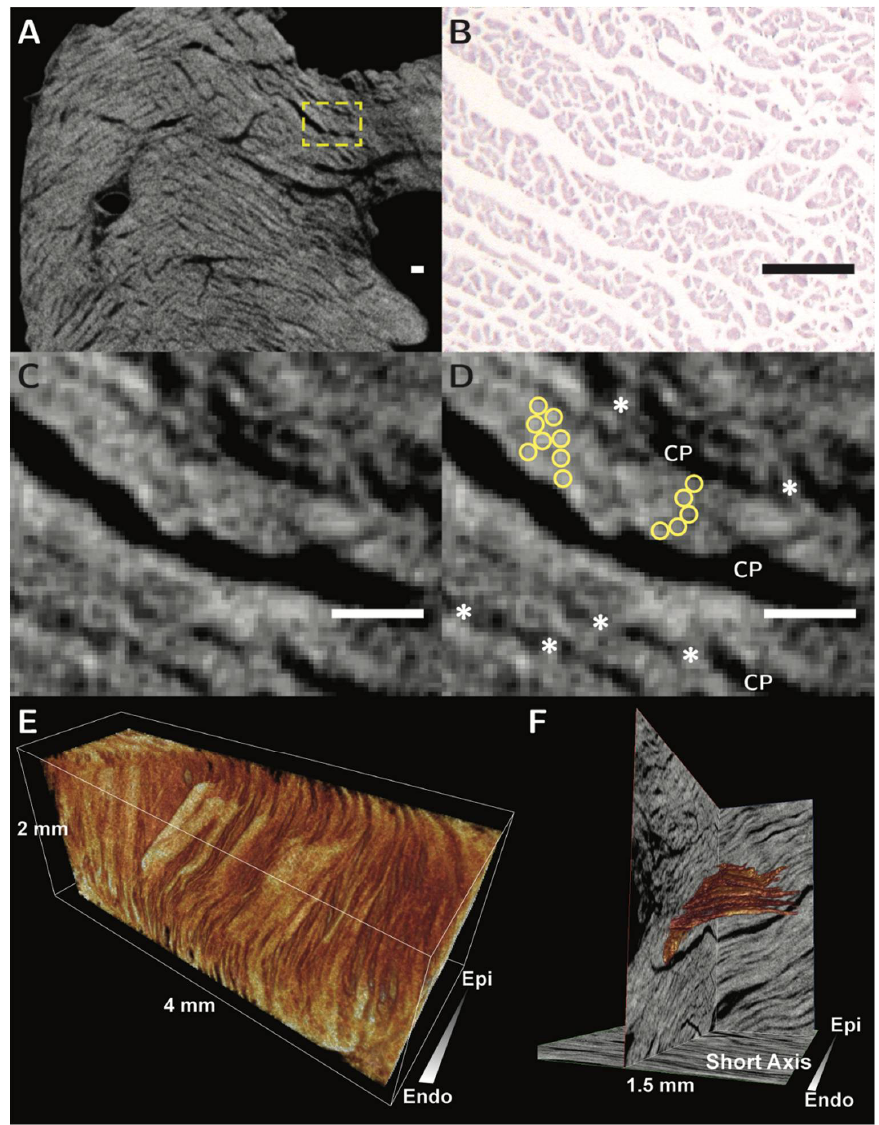
Figure 7. The figure shows the virtual histology of the aggregated units of cardiomyocytes as revealed using micro-computed tomography. Panel ( A ) shows a long axis transmural image obtained from the basal region of the posterior wall of the left ventricle. The arrangement of the cardiomyocytes in the yellow dashed box is then shown in panel ( B ), which is an histological section stained with hematoxylin and eosin, and panels ( C , D ), which are micro-CT images. It is possible, in panel ( D ), to recognize the individual cardiomyocytes, shown in the yellow circles, the branches between adjacent aggregated units, shown by the asterisks, and the cleavage planes (CP) between the units. The scale bars in panels B,C, and D represent 100 µm. Panel ( E ) shows volume rendering of a subendocardial block of rabbit ventricular wall, showing the three-dimensional morphology of multiple aggregates. In Panel ( F ), a solitary aggregated unit of cardiomyocytes, shown in orange, has been reconstructed subsequent to resolution of the contained individual chains of cardiomyocytes. The illustrations are modified from Stephenson et al., 2016 [18]. Our work is now continuing so as to characterize the morphology of the